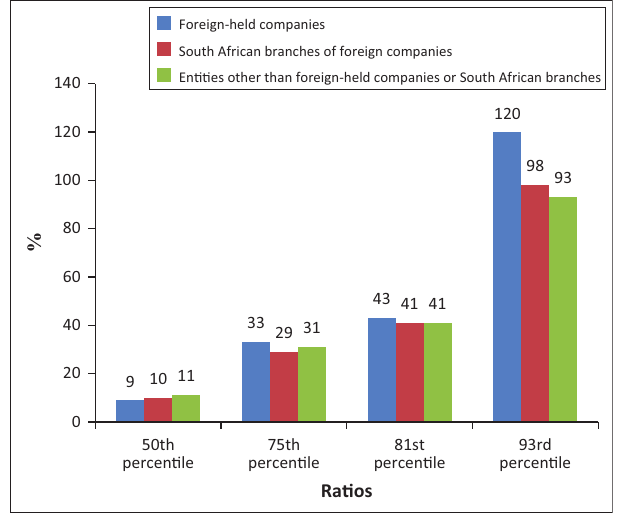
FIGURE 1: Comparison of interest-to-earnings before interest, taxes, depreciation, and amortisation (EBITDA) ratios.